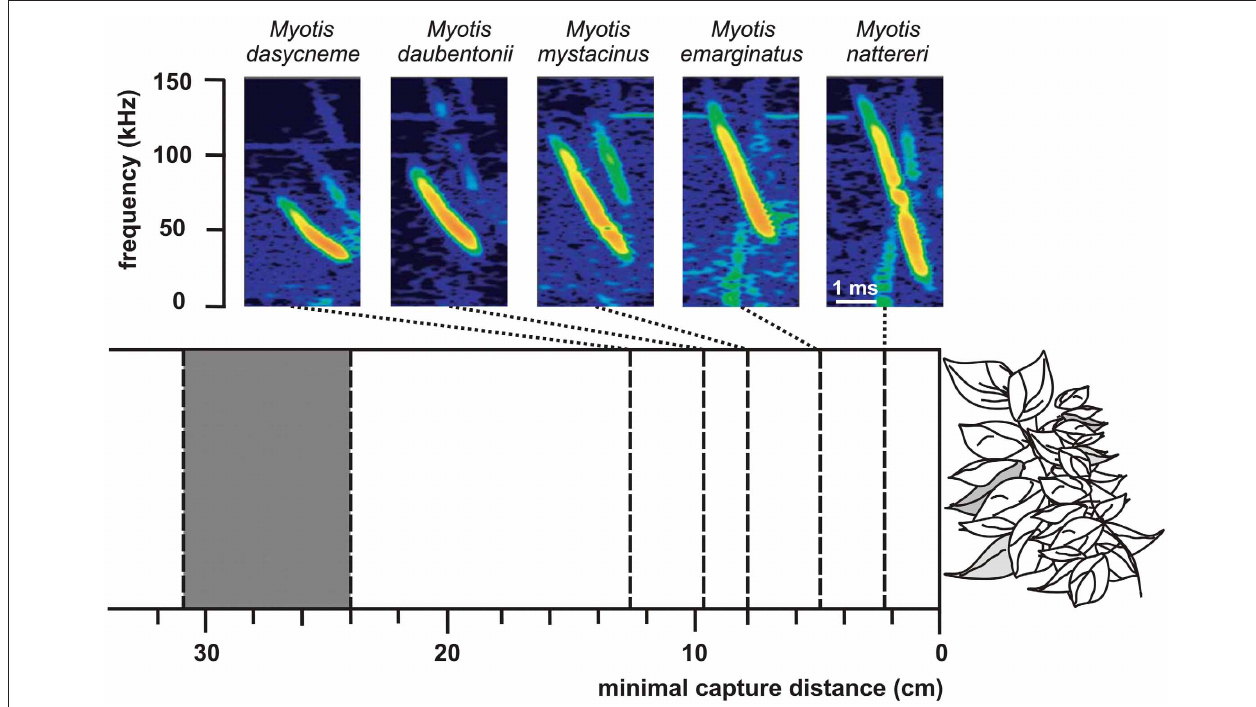
FIGURE 6 | Search call structure in relation to minimal capture distance (success rate 50%) in 5 sympatric Myotis species. The higher the signal bandwidth of a species the lower is the minimal capture distance for suspended mealworms. The gray block between 24 and 31cm indicates the